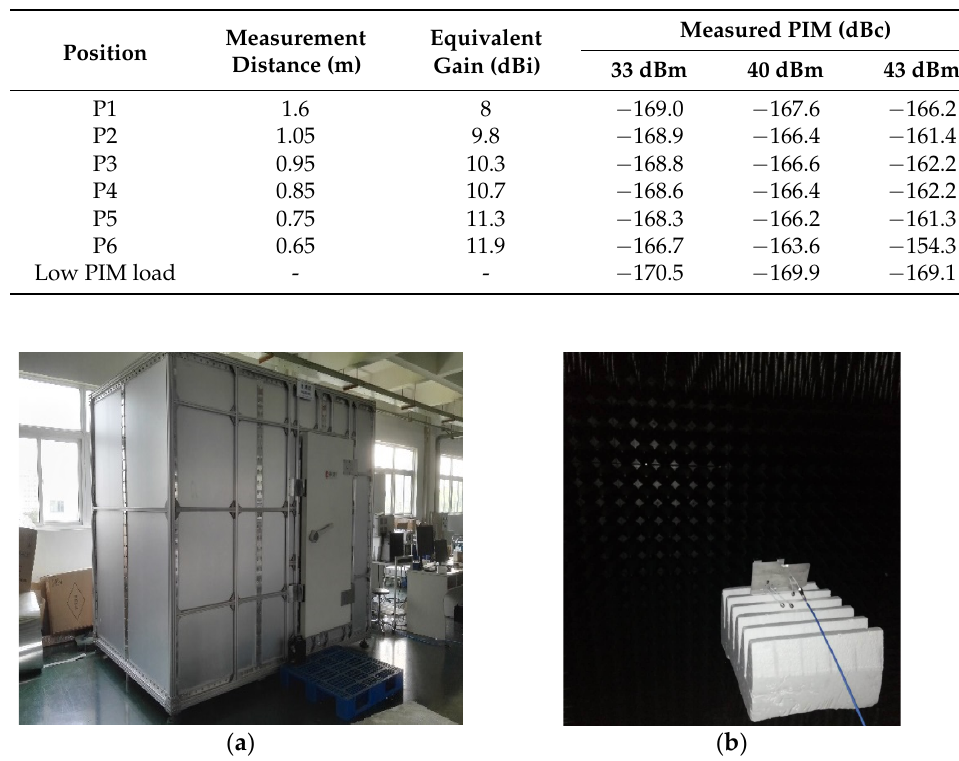
Figure 8. A photograph of chamber B. ( a ) Appearance of the PIM measurement chamber A, ( b ) measurement arrangement in PIM measurement chamber B.